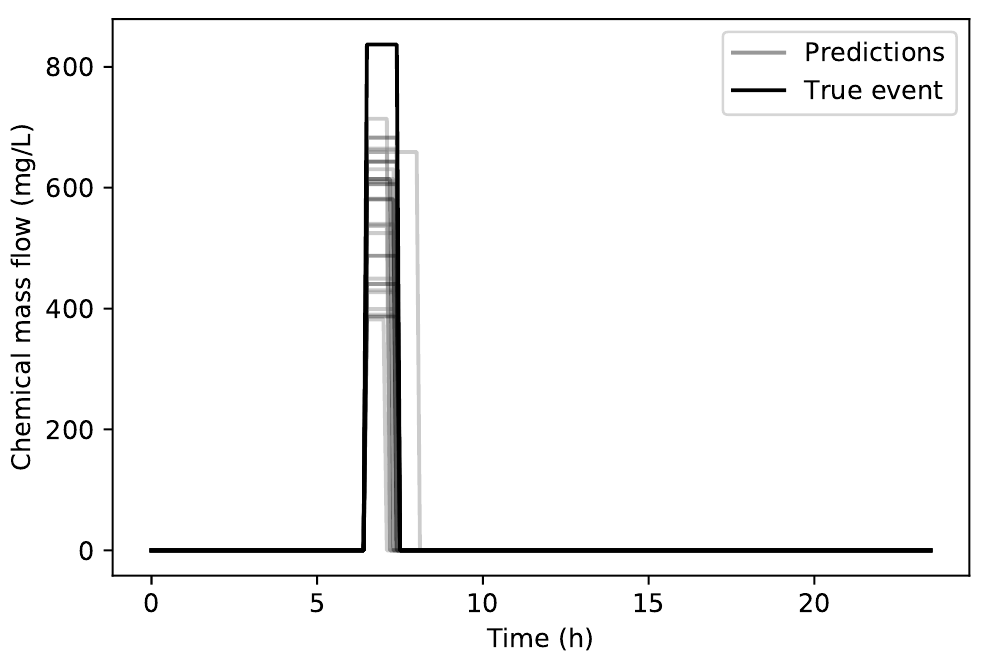
Figure 10. Richmond network true contamination event (black) and predicted contamination events (grey).